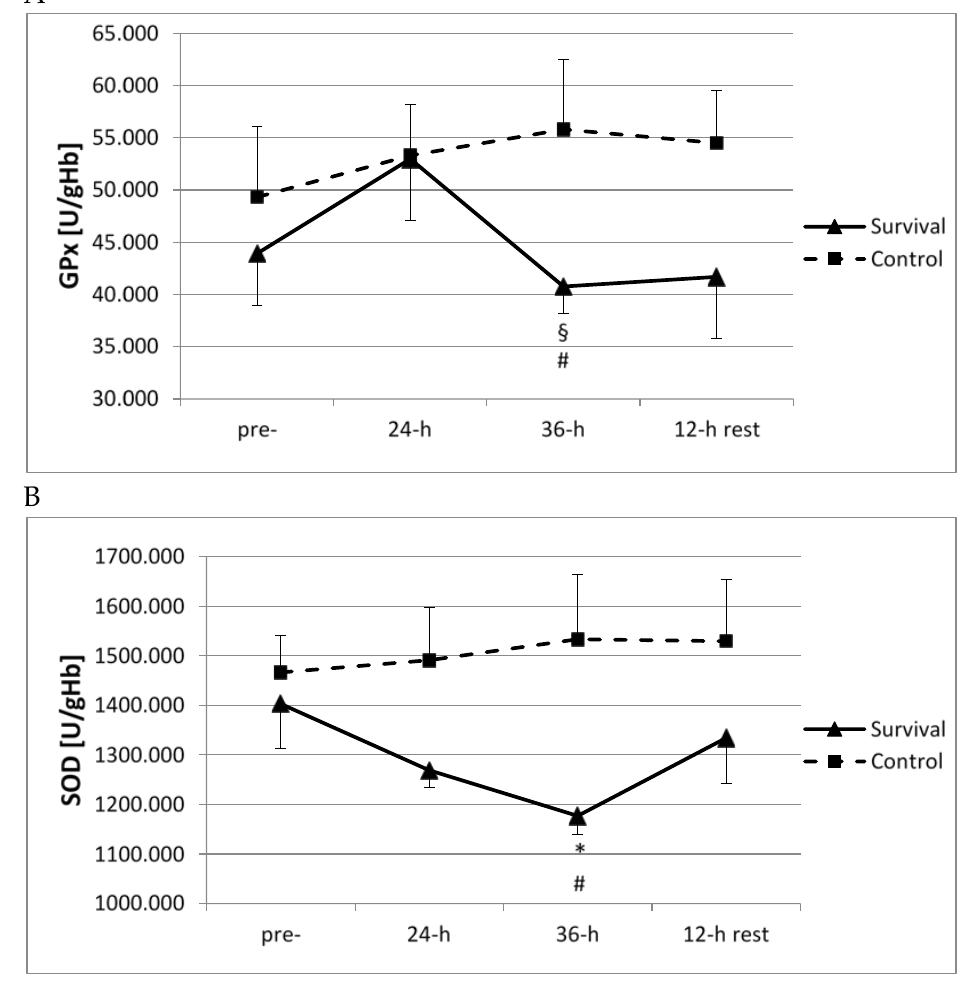
Figure 4. Changes in the activity of antioxidant enzymes in control group ( n = 11) and survival group ( n = 12). ( A ) Changes in whole blood activity of glutathione peroxidase (GPx) (U/gHb). Values are means ± SD. Main effects: group ( p = 0.038); § significant difference ( p < 0.05) as compared to 24-h (within same group); # significant difference ( p < 0.05) between survival and control groups (at same time point); ( B ) Changes in erythrocyte activity of superoxide dismutase (SOD) (U/gHb). Values are means ± SD. Main effects: group ( p = 0.045); * significant difference ( p < 0.05) as compared to pre-training (within same group); # significant difference ( p < 0.05) between survival and control groups (at same time point).